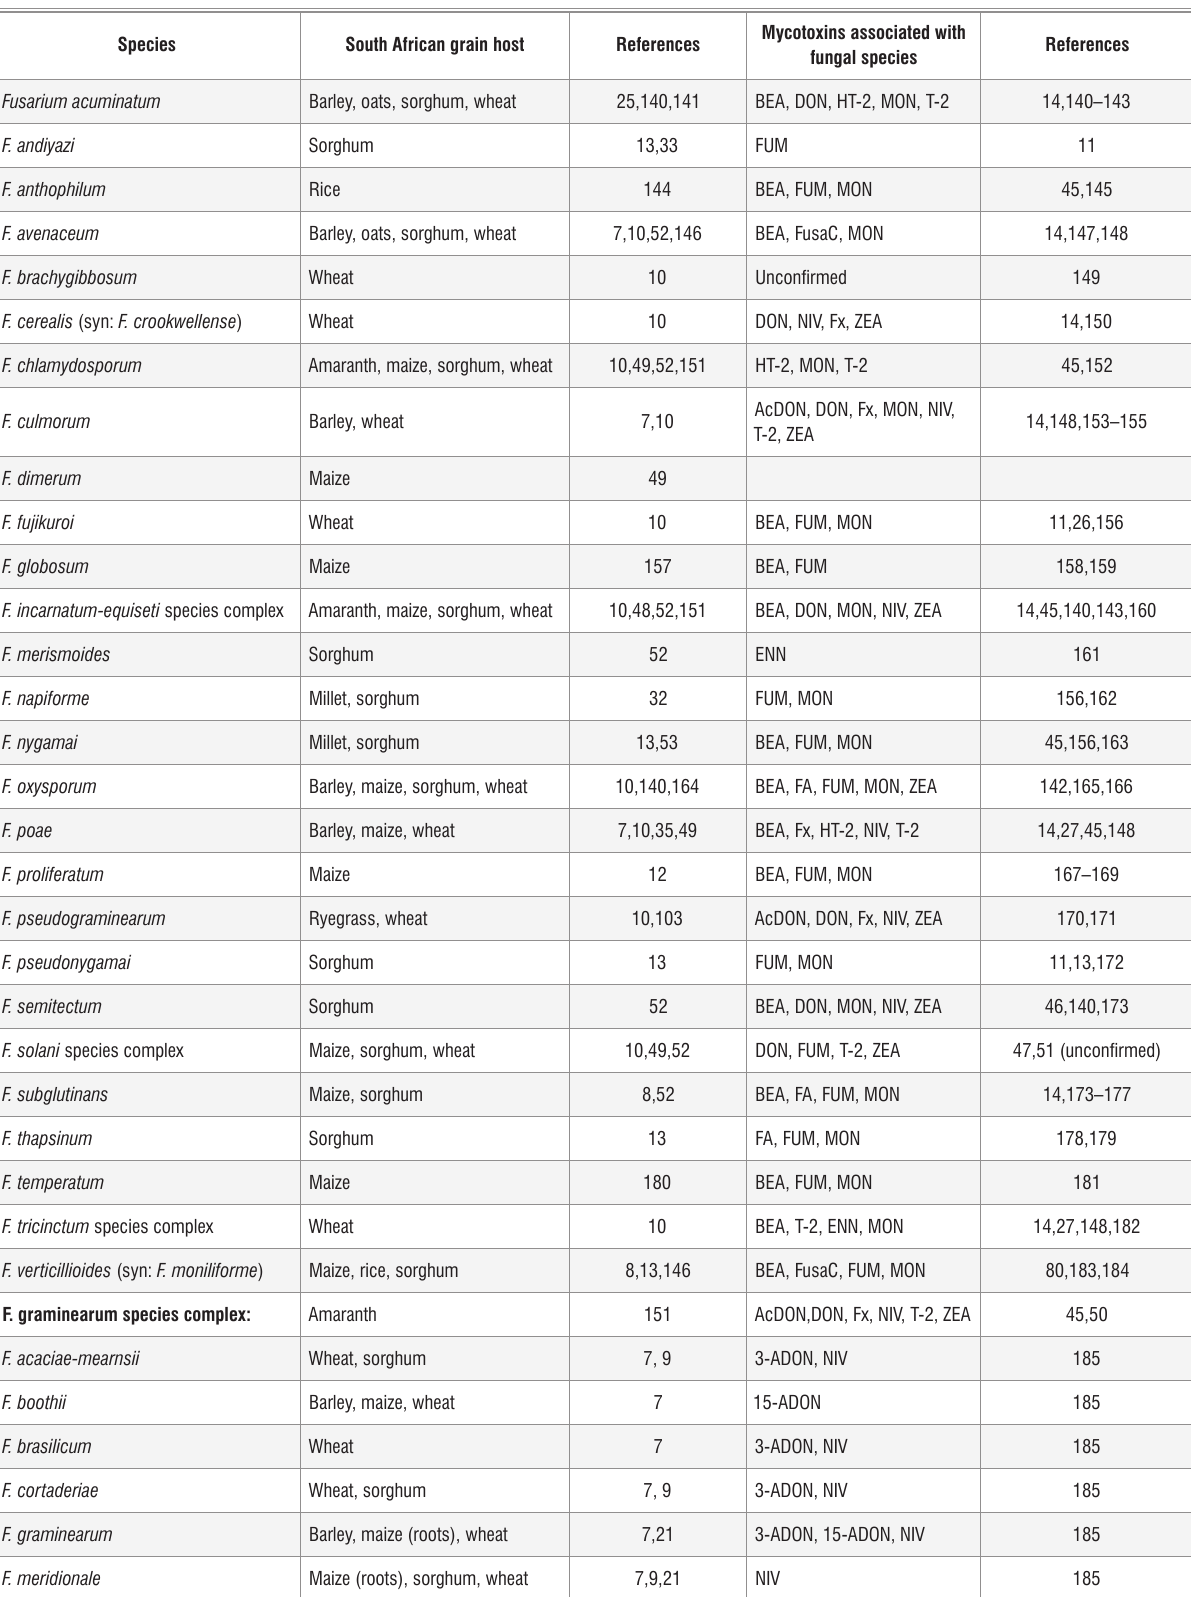
Table 1: Mycotoxigenic Fusarium species associated with South African grain crops Species South African grain